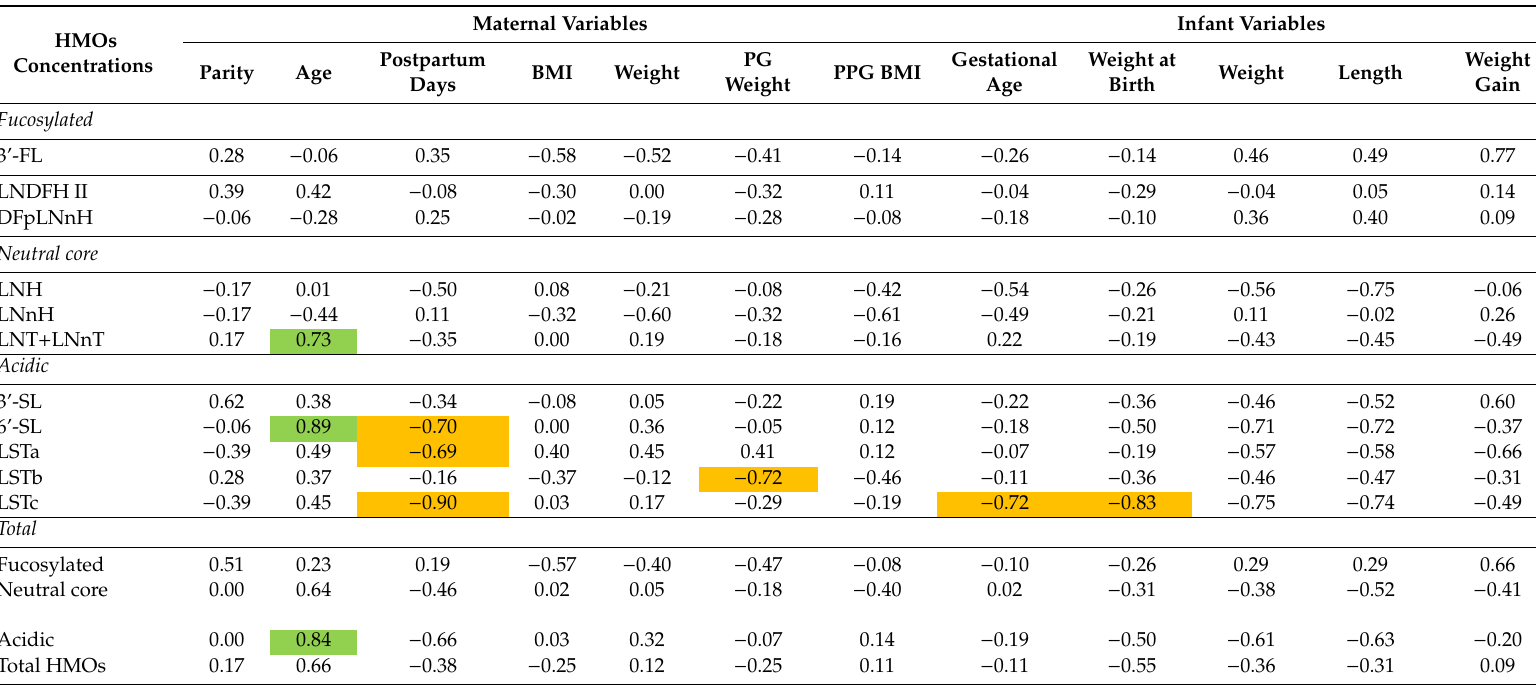
Table A1. Spearman rank correlation coe ffi cient (r) between HMOs concentrations and quantitative clinical variables in Group 2 (Se − Le + ; n =